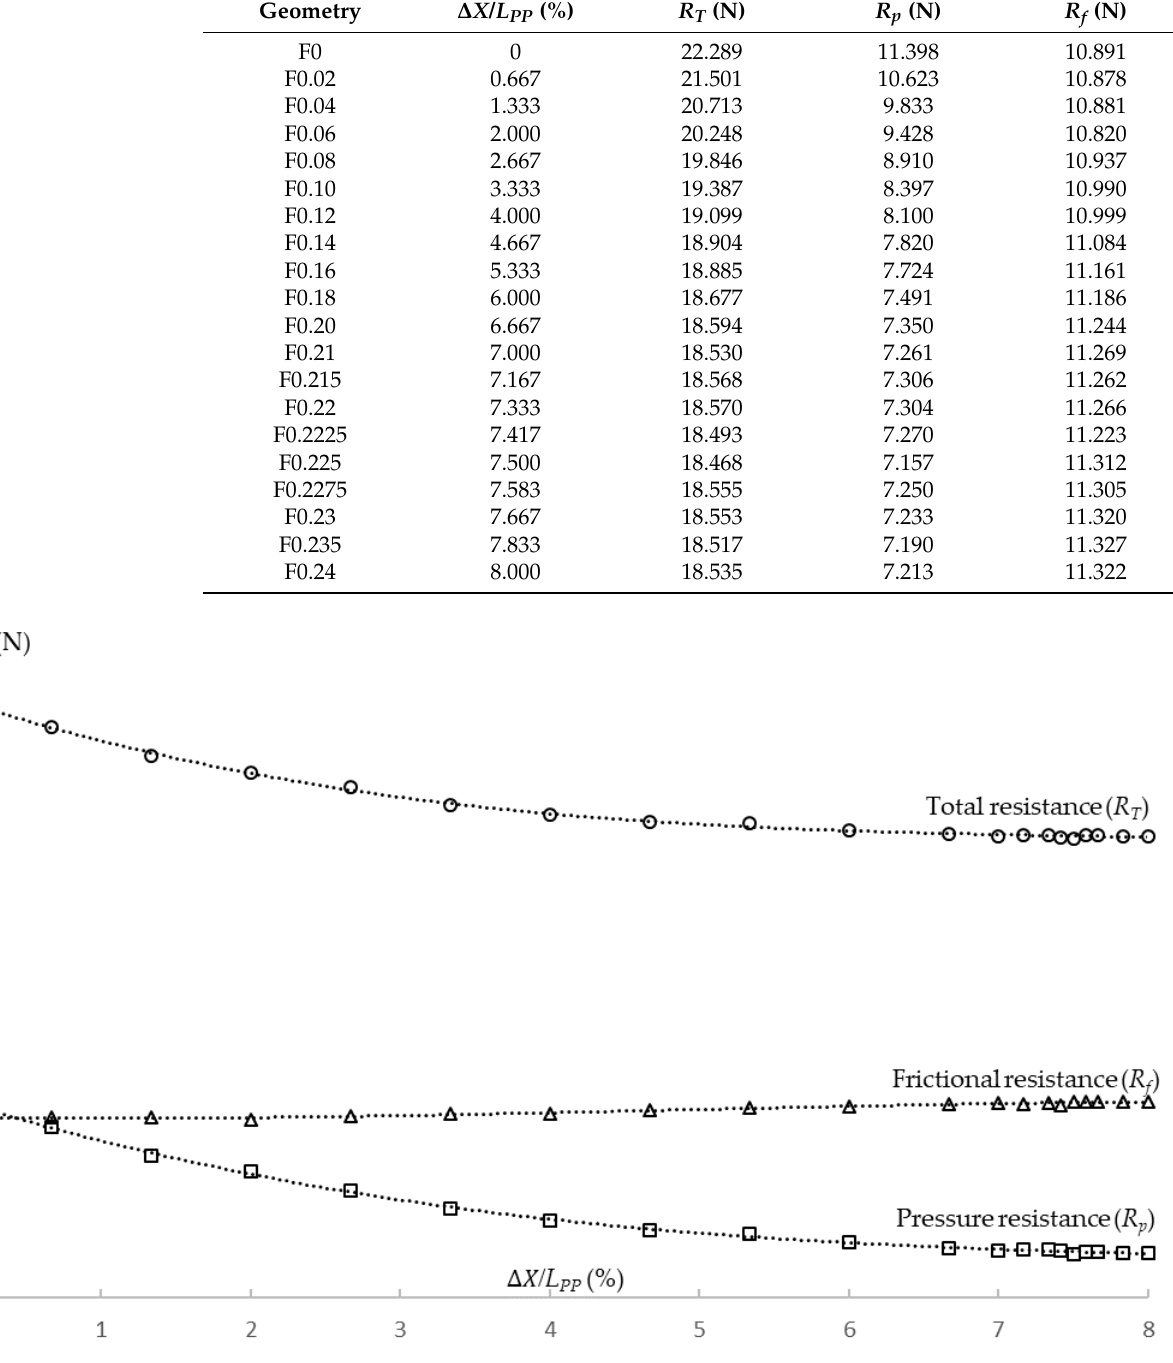
Figure 6. Resistance trend. As R = ( R T , R p , R p ), the total resistance reduction R d ( R T ), pressure resistance reduction R d ( R p ), and frictional resistance reduction R d ( R f ) is calculated, respectively. The trend